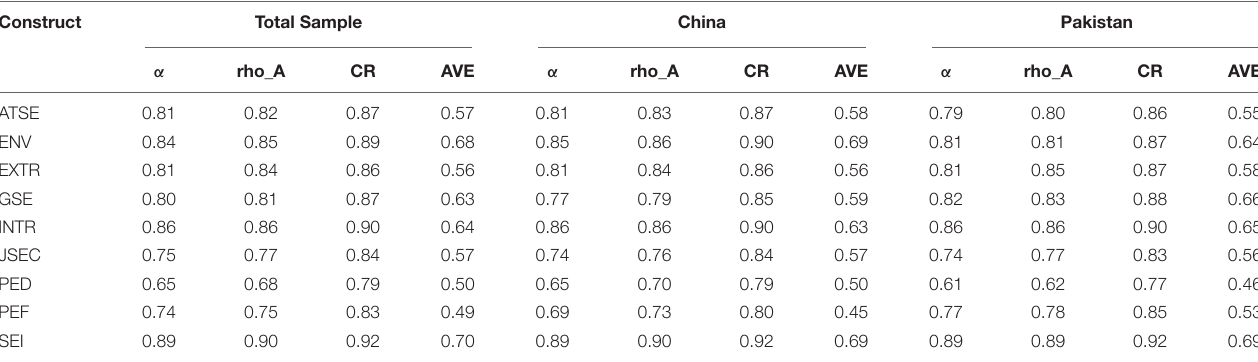
TABLE 2 | Construct reliability and validity of China vs.